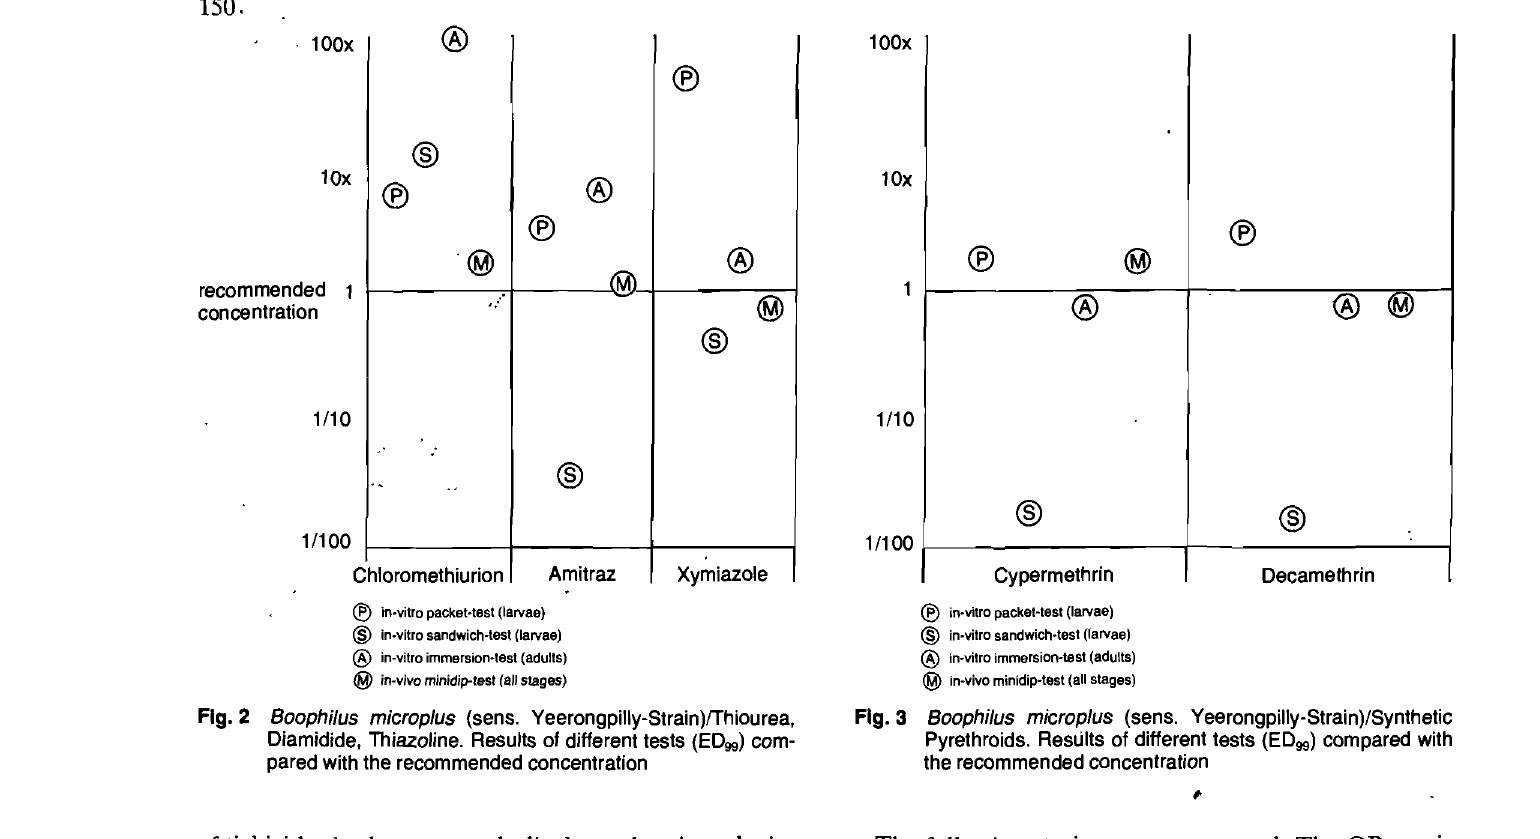
Fig. 3 Boophilus microplus (sens, Yeerongpilly-Strain)/Synthetic Pyrethroids, Results of different tests (EDgg) compared with the recommended concentration ,.